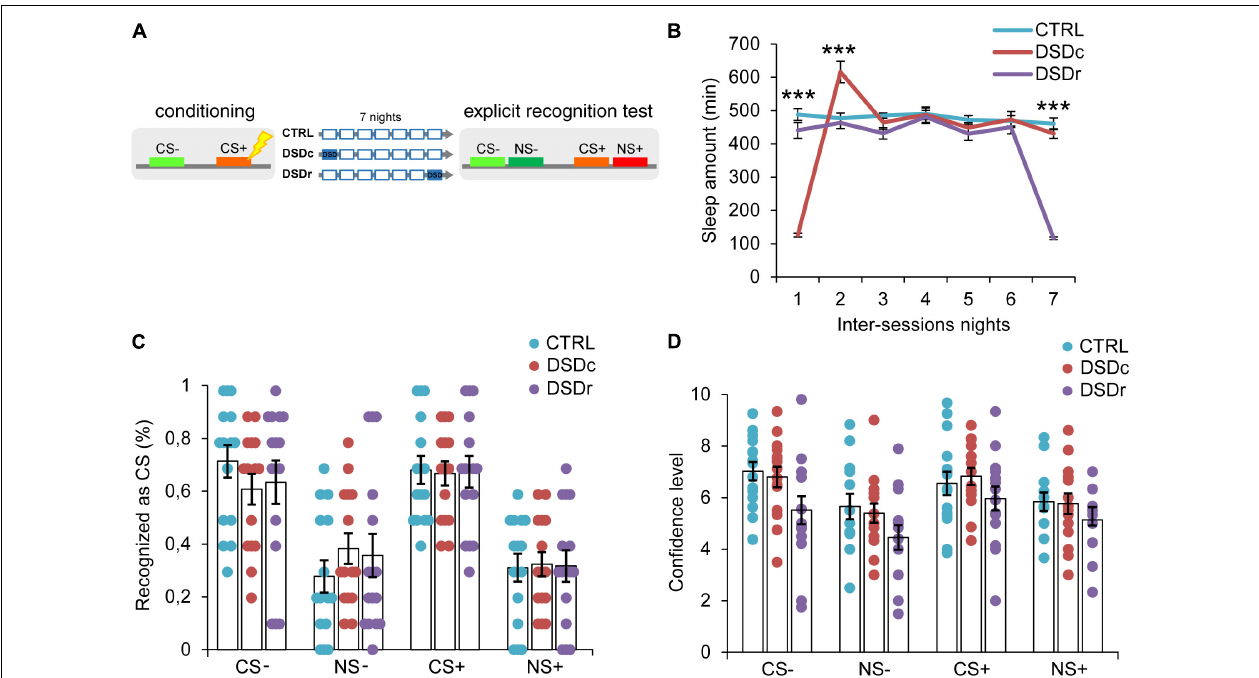
FIGURE 2 | Effects of DSD on explicit threat memories, safety memories, and threat generalization to new stimuli. (A) Schematic diagram depicting the experimental design. Participants underwent a differential threat conditioning in which a conditioned tone (CS+) was paired with a mild electrical shock (US) and a non-reinforced tone (CS–) was never paired with the US. One group of participants (CTRL, n = 15) was allowed to regularly sleep during the seven nights between the sessions. The other two groups were sleep-deprived during the night after the first session (DSDc, n = 15) or during the night before the second session (DSDr, n = 15). One week after the conditioning session, subjects underwent an explicit 2AFC recognition task during which they were presented with tone pairs composed of a conditioned stimulus (CS– or CS+) and a new stimulus similar to the CS– (NS–) or the CS+ (NS+) and they were asked to recognize the CS– and the CS+, providing a confidence level for each choice. (B) Actigraphically controlled sleep distributions of each group over the seven nights separating the experimental sessions. (C) Explicit recognition patterns for correct (CS– and CS+) and incorrect (NS– and NS+) choices were comparable between groups. (D) Confidence ratings for correct (CS– and CS+) and incorrect (NS– and NS+) choices were similar amongst conditions. *** P < 0.001. All data are mean and SEM. 3 × 7 mixed ANOVA followed by Bonferroni corrected simple main effect analyses (B) ; 3 × 4 mixed ANOVA (C,D)